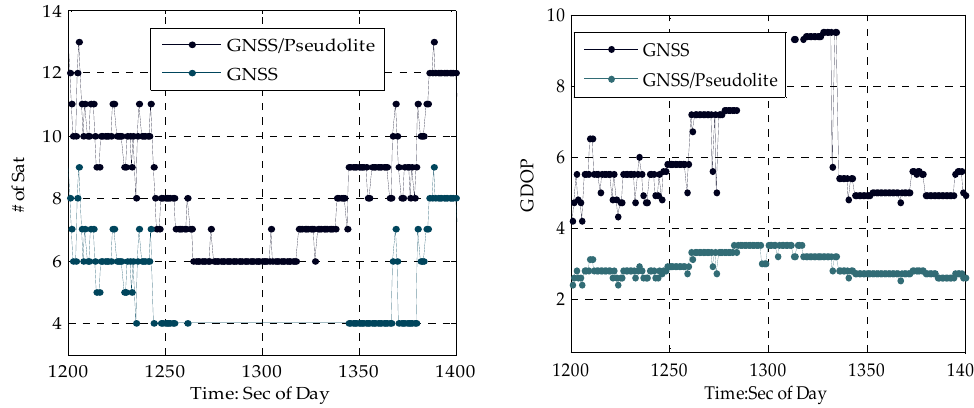
Figure 5. Time series of the number of satellites and DOP PDOP (Position Dilution of Precision).